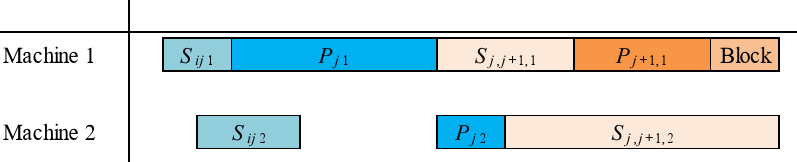
Fig. 1. Example of a blocking flow shop scheduling problem with setup